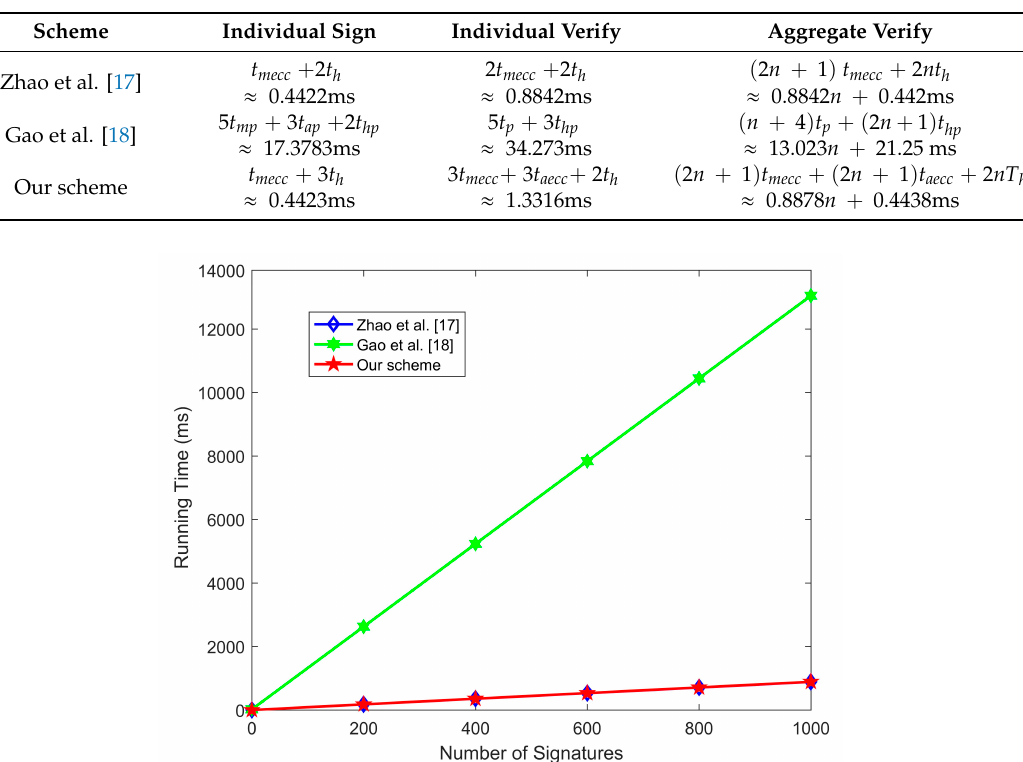
Figure 5. The aggregate verification cost of schemes based on blockchain.